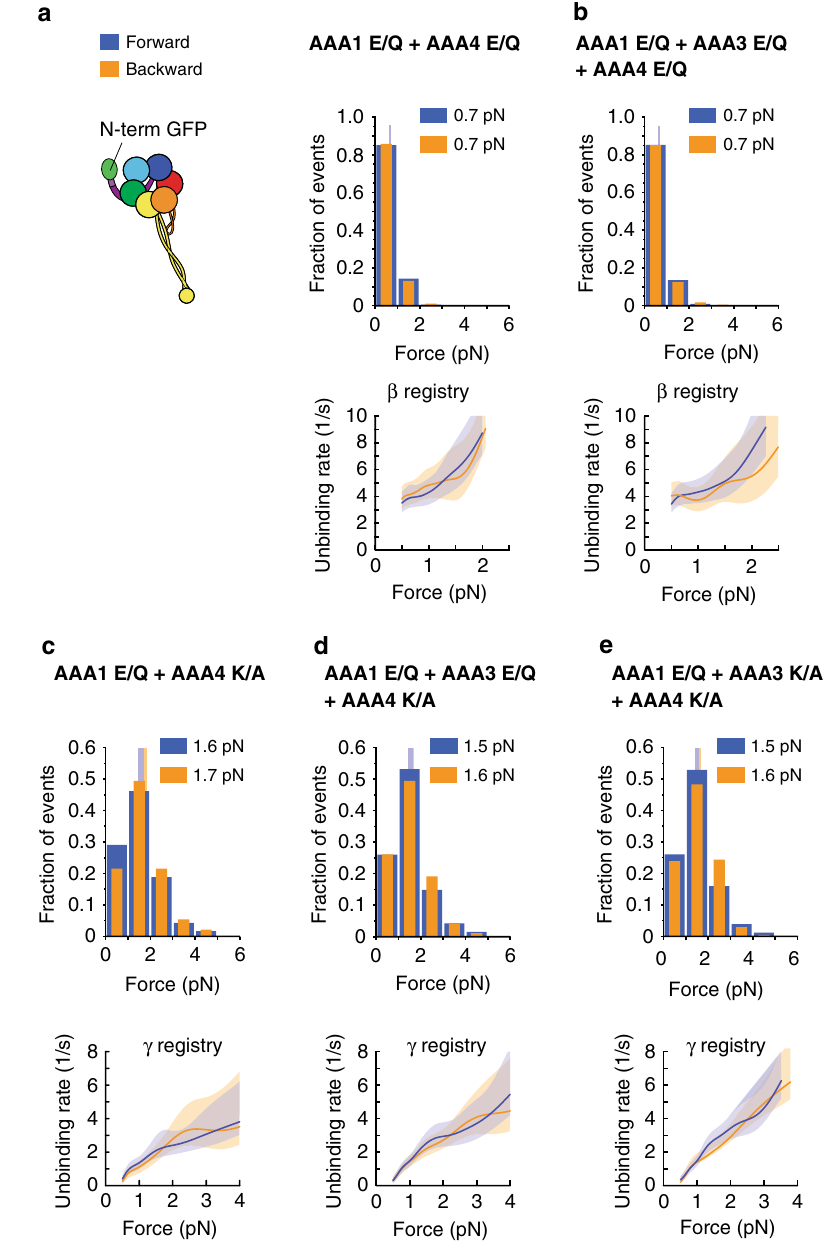
Fig. 4 Blocking AAA4-ATP binding induces the γ registry irrespective of the AAA3 nucleotide state. a (Left) Schematic of dynein with GFP fused to the N-terminus. (Right) Histogram of forward (blue) and backward (orange) unbinding forces for the AAA1 E/Q + AAA4 E/Q-GFP-Dyn1 331kDa double mutant measured in the presence of 1 mM ATP. The respective mean values are noted. The vertical bands represent 95% CIs for the means (forward: [0.6, 0.7] pN, backward [0.6, 0.7] pN). (Bottom) Unbinding rate vs. force derived from the data above. The shaded areas are the 95% CIs for the mean rates, which were estimated by bootstrapping. b Same as in a , but for the AAA1 E/Q + AAA3 E/Q + AAA4 E/Q-GFP-Dyn1 331kDa triple mutant (95% CIs [0.6, 0.7] and [0.6, 0.7] pN). c Same as in a , but for the AAA1 E/Q + AAA4 K/A-GFP-Dyn1 331kDa double mutant (95% CIs [1.4, 1.7] and [1.5, 1.9] pN). d Same as in a , but for the AAA1 E/Q + AAA3 E/Q + AAA4 K/A-GFP-Dyn1 331kDa triple mutant (95% CIs [1.4, 1.7] and [1.5, 1.7] pN). e Same as in a , but for the AAA1 E/Q + AAA3 K/A + AAA4 K/A-GFP-Dyn1 331kDa triple mutant (95% CIs [1.4, 1.6] and [1.5, 1.7] pN). The number of events in the forward and backward directions: ( a ) (321,358), ( b ) (419, 382), ( c ) (117, 93), ( d ) (188,172), and ( e ) (257, 205). Source data are provided as a Source Data fi